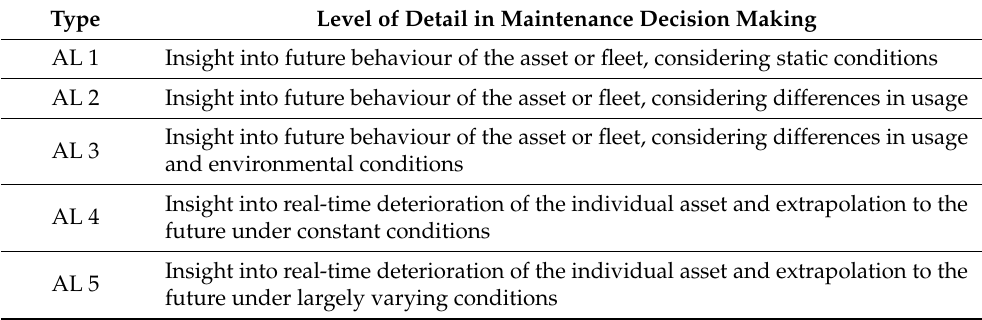
Table 1. Definition of different ambition levels.